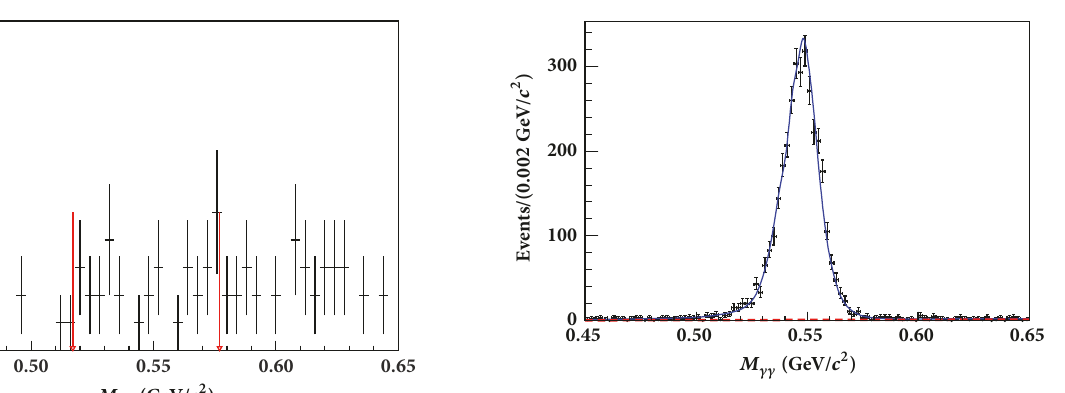
Figure 5: The 𝑀 𝛾 spectra of candidate events from 106 million 2 𝛾 3 inclusive 𝜓(3686) MC samples (dots with error bar). The solid line shows the best fitting to the spectra and the dashed line shows the